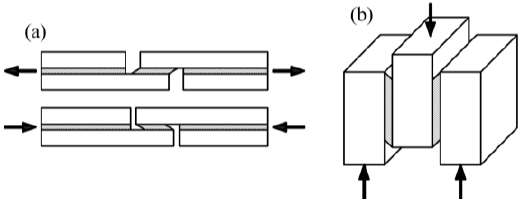
Figure 1. Configurations for testing lap joints in glue laminated timber (GLT— a ) single-lap joint, ( b ) double-lap joint.